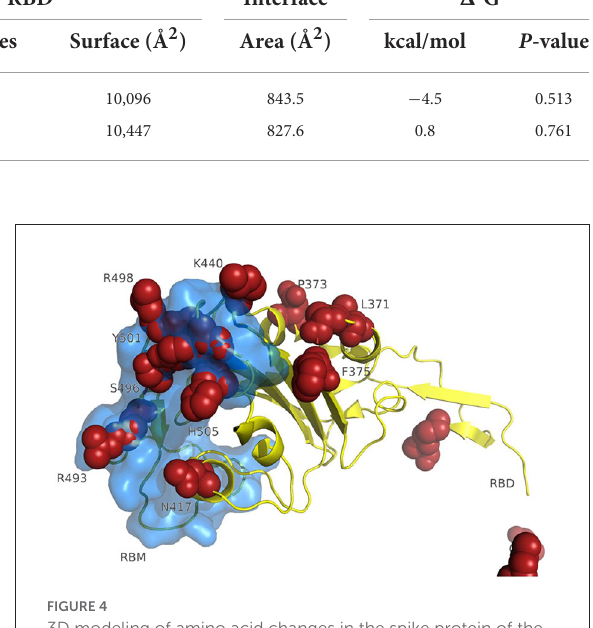
FIGURE4 3D modeling of amino acid changes in the spike protein of the Omicron variant. Receptor-binding domain (yellow); RBM-receptor-binding motif (blue); B.1.1.529 mutations in